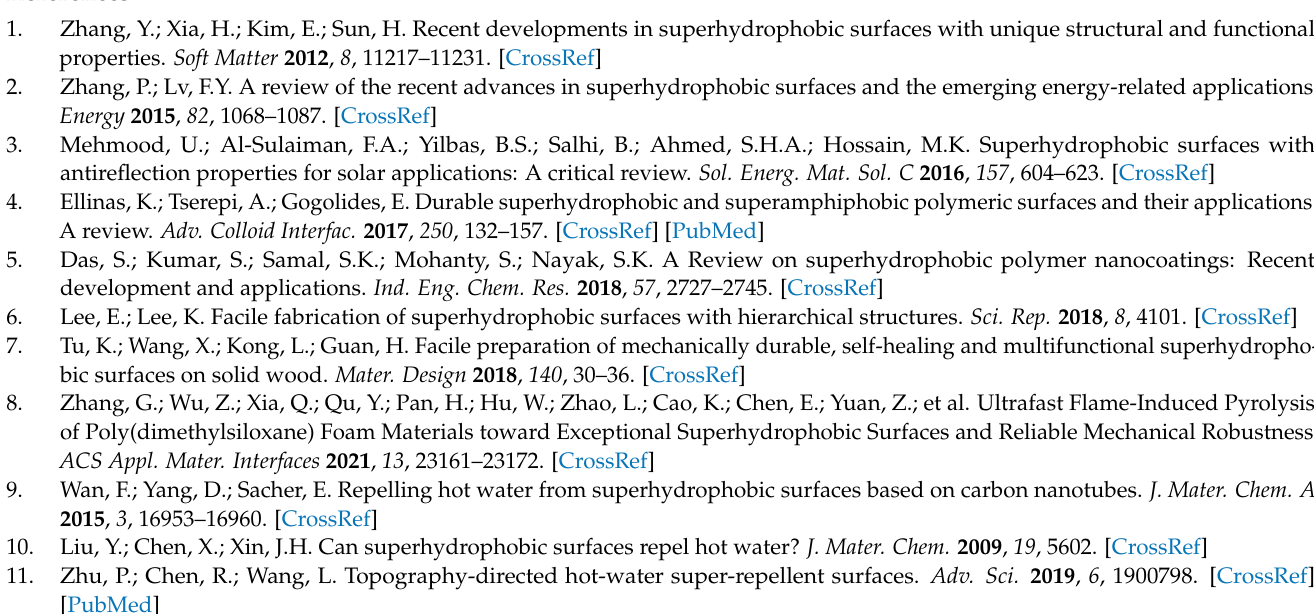
tact angle between hot-water droplets at 90 ◦ C and HWRS in 1 min; Figure S4: The change in droplet temperature in 1 min; Figure S5: The size of the sand used for self-cleaning test; Figure S6: Optical and infrared images of high-temperature droplets on surface fabricated at T d = 390 ◦ C; Figure S7: The change of contact angle with the increase of time during the natural cooling of high-temperature droplets; Figure S8: The θ and θ s of hot acid and hot base on the HWRS: (a) acid, (b) base; Figure S9: The antifouling test of HWRS; Figure S10: Low adhesion between HWRS and ethylene glycol droplet; Figure S11: The θ and θ s of water on the HWRS immersed in oil: (a) petroleum ether, (b) n-hexane and (c) n-heptane; Figure S12: Sequential images showing the self-cleaning property of the HWRS by an infrared camera; Figure S13: The calibration of the infrared camera; Movie S1: The CA of 90 ◦ C droplets in HWRS in 1 min; Movie S2: Bouncing dynamics of impacting water droplets at T w of 22 ◦ C, 60 ◦ C and 90 ◦ C on HWRS; Movie S3: Self-cleaning behavior of the HWRS im- mersed into the petroleum ether; Movie S4: Self-cleaning behavior of the HWRS through hot water; Movie S5: Self-cleaning behavior of the HWRS by falling water in condensation